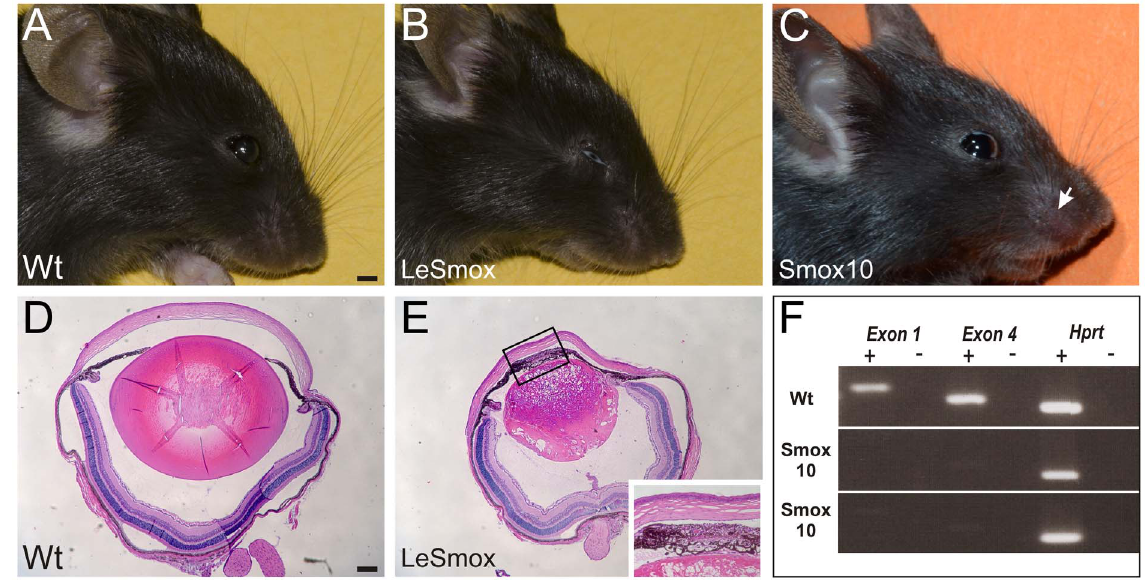
Figure 3. Ocular phenotype of Smo cKO mice. Images showing normal ocular phenotype in weanling (4 week old) wild-type ( A ) and Smox10 mice ( C ) but microphthalmia in LeSmox ( B ) mice. Smox10 mice lacked hair between whiskers ( C , white arrow), due to ectopic Cre activity in these follicles. Histology confirmed microphthalmia in P21 LeSmox ( E ) mice compared to wild-type ( D ). The phenotype was characterized by abnormal lens development, reduction of the anterior chamber, overlapping irises and fusion of the iris to the lens (E, inset). F. RT-PCR showed no expression of Smo gene in two independent Smox10 lenses at P2, using primers specific for exons1 or 4, but normal expression of Hprt . Presence ( + ) or absence ( 2 ) of reverse transcriptase in reactions is indicated above the lanes. Scale bar A–C , 2 mm; D–E , 50 m m; inset, 90 m m.